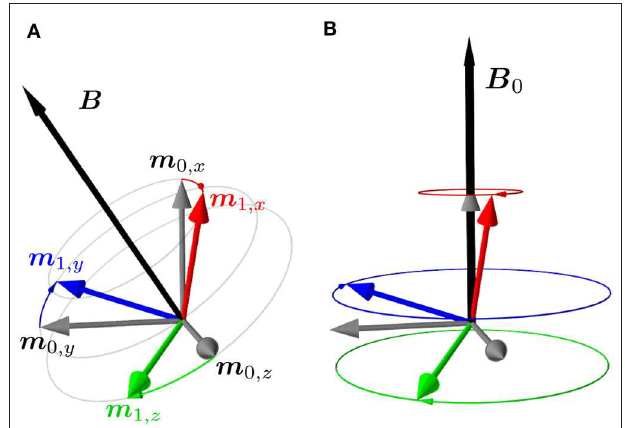
FIGURE 1 | (A) Rotation of three orthogonal starting magnetizations m 0, x m 0 e x , m 0, y m 0 e y , and m 0, z = | | = | | B B B B J during the zero-field time. (B) After the zero-field time, the main = + B 0 e x ( B 0 B field B 0 ) is turned on and the vectors start rotating about = | | | | ≫ | | e x